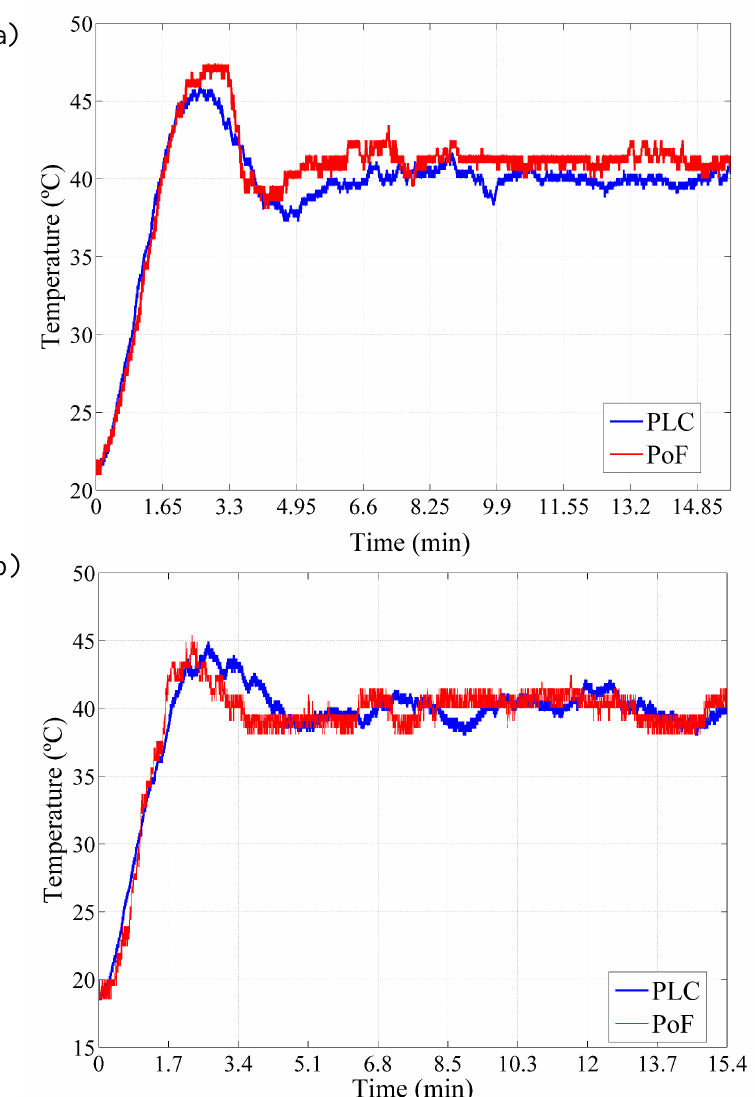
Figure 9. Temperature comparison between the PoF-based approach and the conventional industrial PLC (first scenario): ( a ) Temperature measurements acquired from the TX node 1. ( b ) Temperature measurements acquired from the TX node